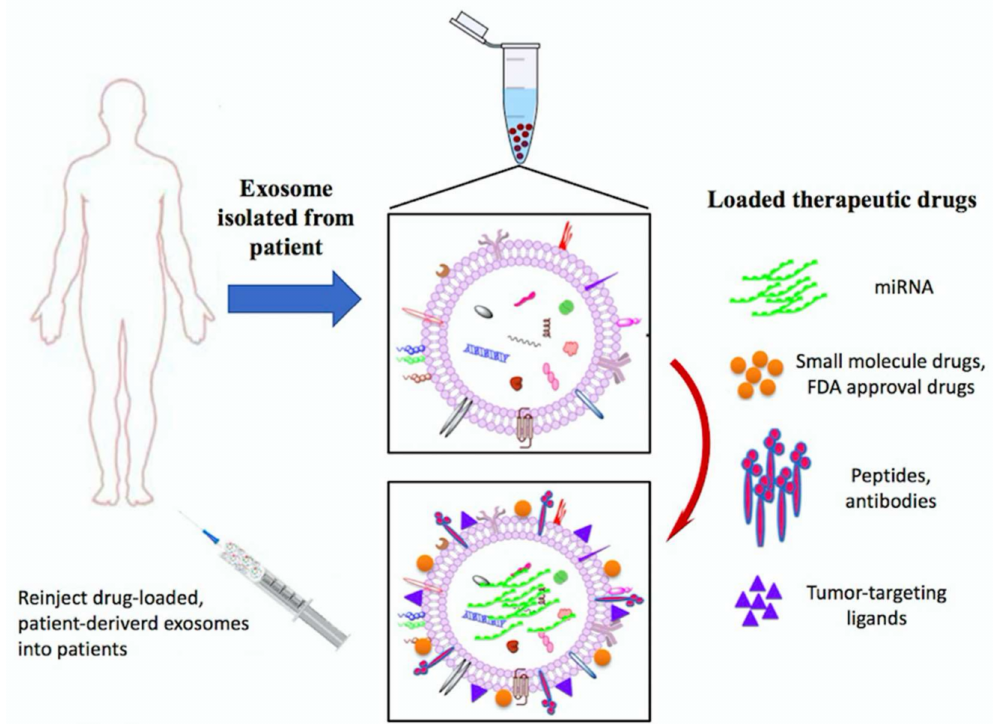
Figure 6. Exosomes as anti-cancer drug delivery